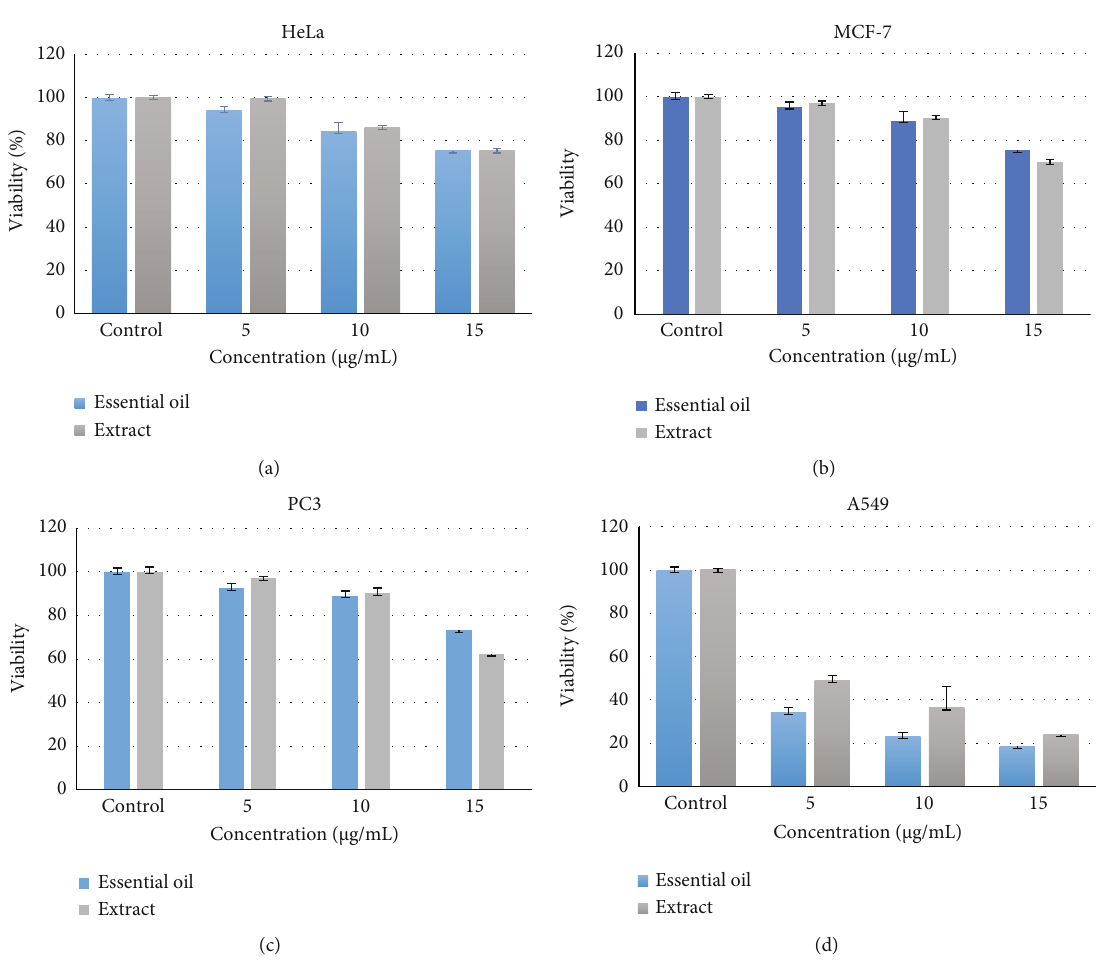
Figure 1: Cytotoxicity of D. ammoniacum oleo-gum resin extract and essential oil against cell lines. (a) HeLa cell line, (b) MCF7 cell line, and (c) PC3 cell line. (d) The e ff ect of aqueous extract of D. ammoniacum oleo-gum resin on the survival of A549 cells. Survival was measured by MTT method. The results are expressed as mean ± SD of three independent experiments ( n = 3